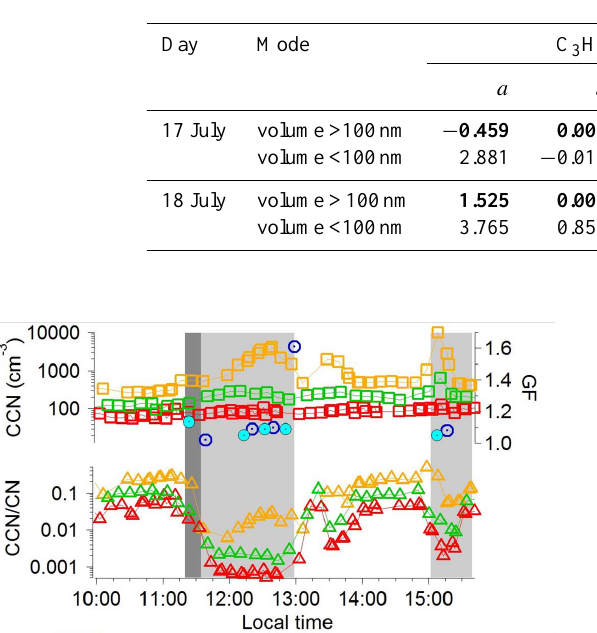
Table 3. Correlations ( a = intercept; b = slope; n = number of samples) between the fragments C 2 H 3 O + and C 3 H + for the large and the small mode. Bold: correlation is statistically significant at the 99% level. C 3 H + days; C 2 H 3 O + correlates with the small mode on 17 July.